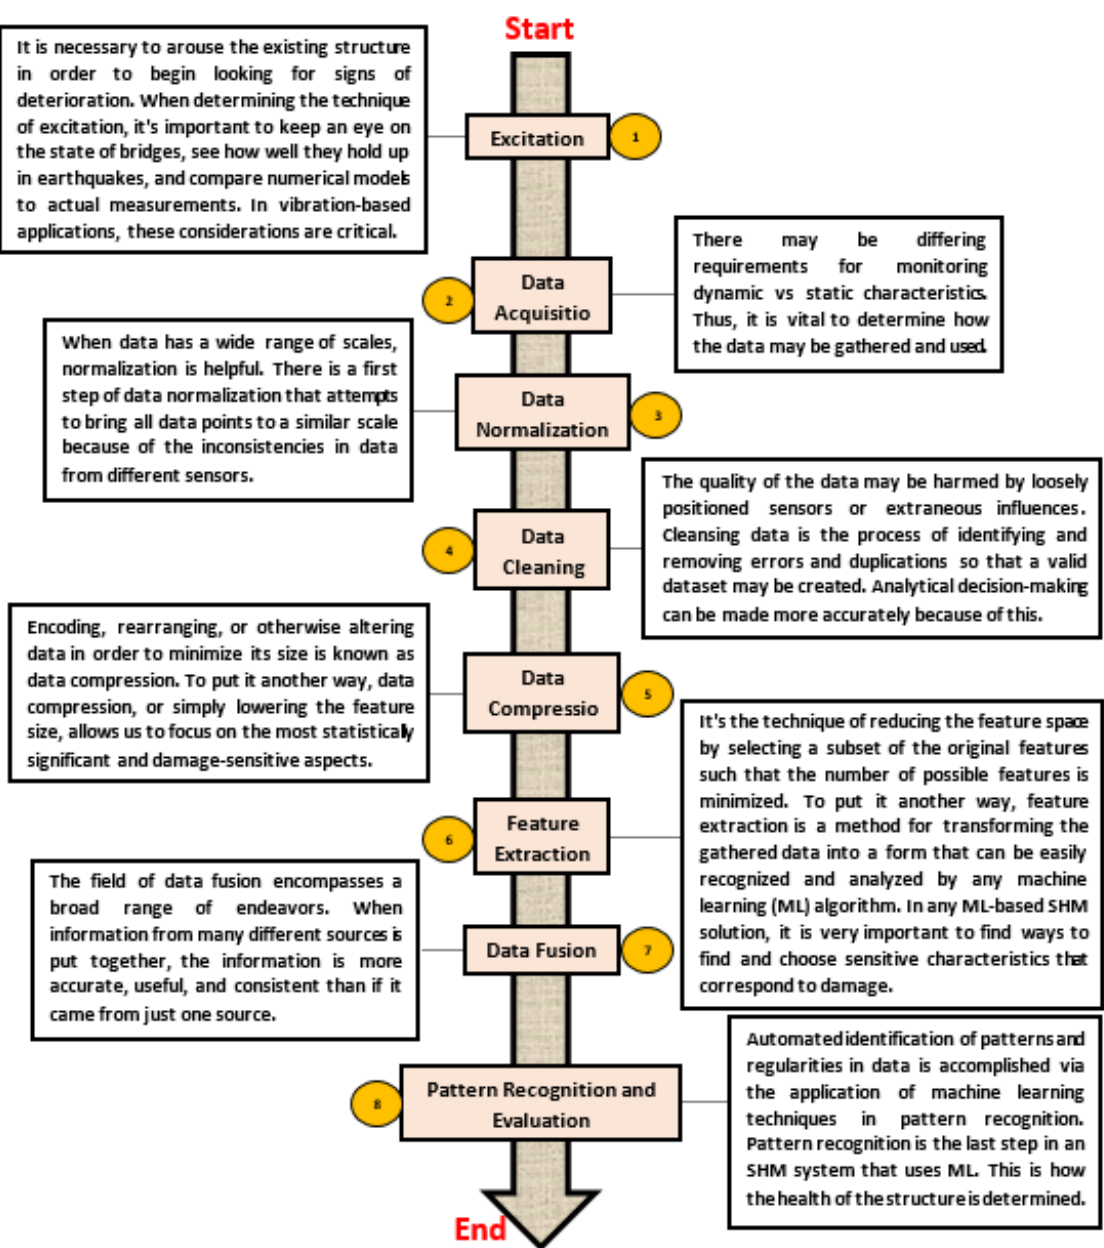
Figure 3. An outline of the eight stages required to implement a data-driven SHM system.